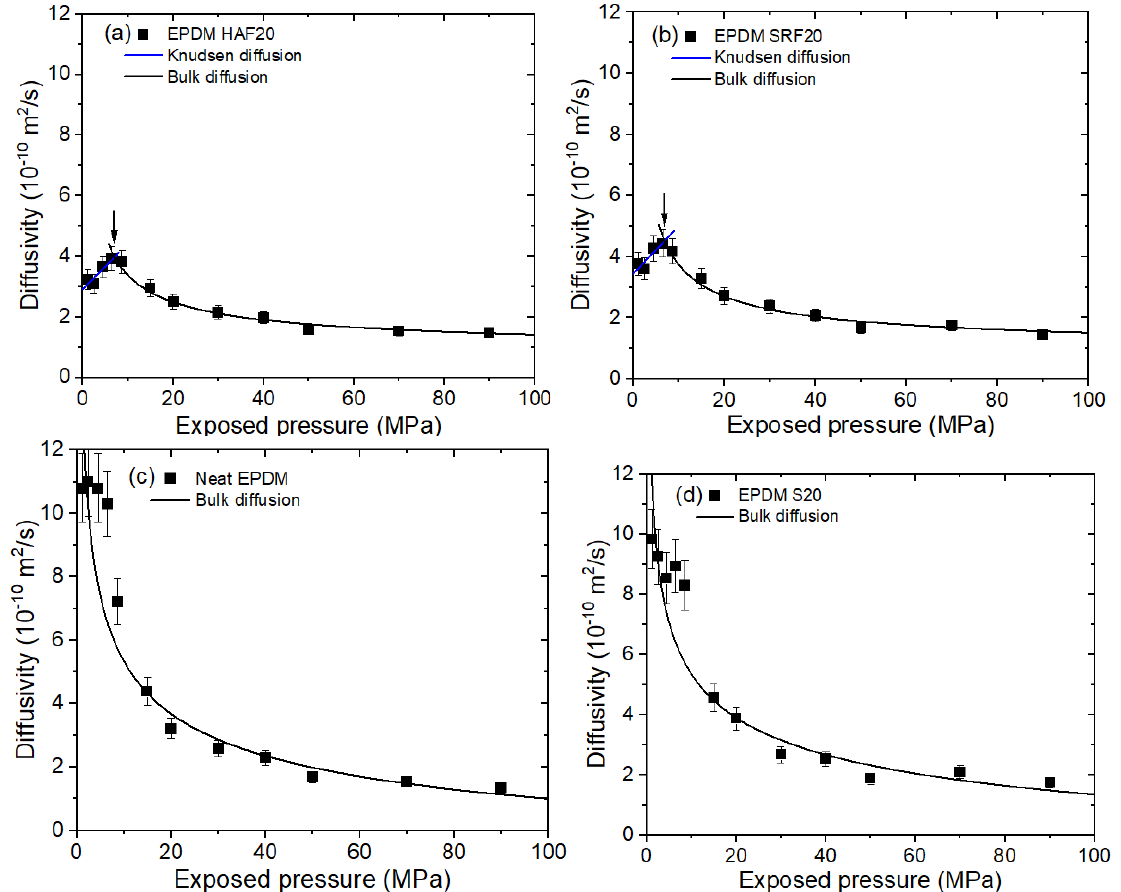
Figure 5. H 2 diffusivity versus exposed pressure in ( a ) EPDM HAF20, ( b ) EPDM SRF20, ( c ) neat EPDM, and ( d ) EPDM S20. The blue lines indicate the Knudsen diffusion data fitted with Equation (4). The black lines indicate the bulk diffusion data fitted with Equation (5). The arrows in ( a , b ) indicate the intersection regions for Knudsen and bulk diffusion.